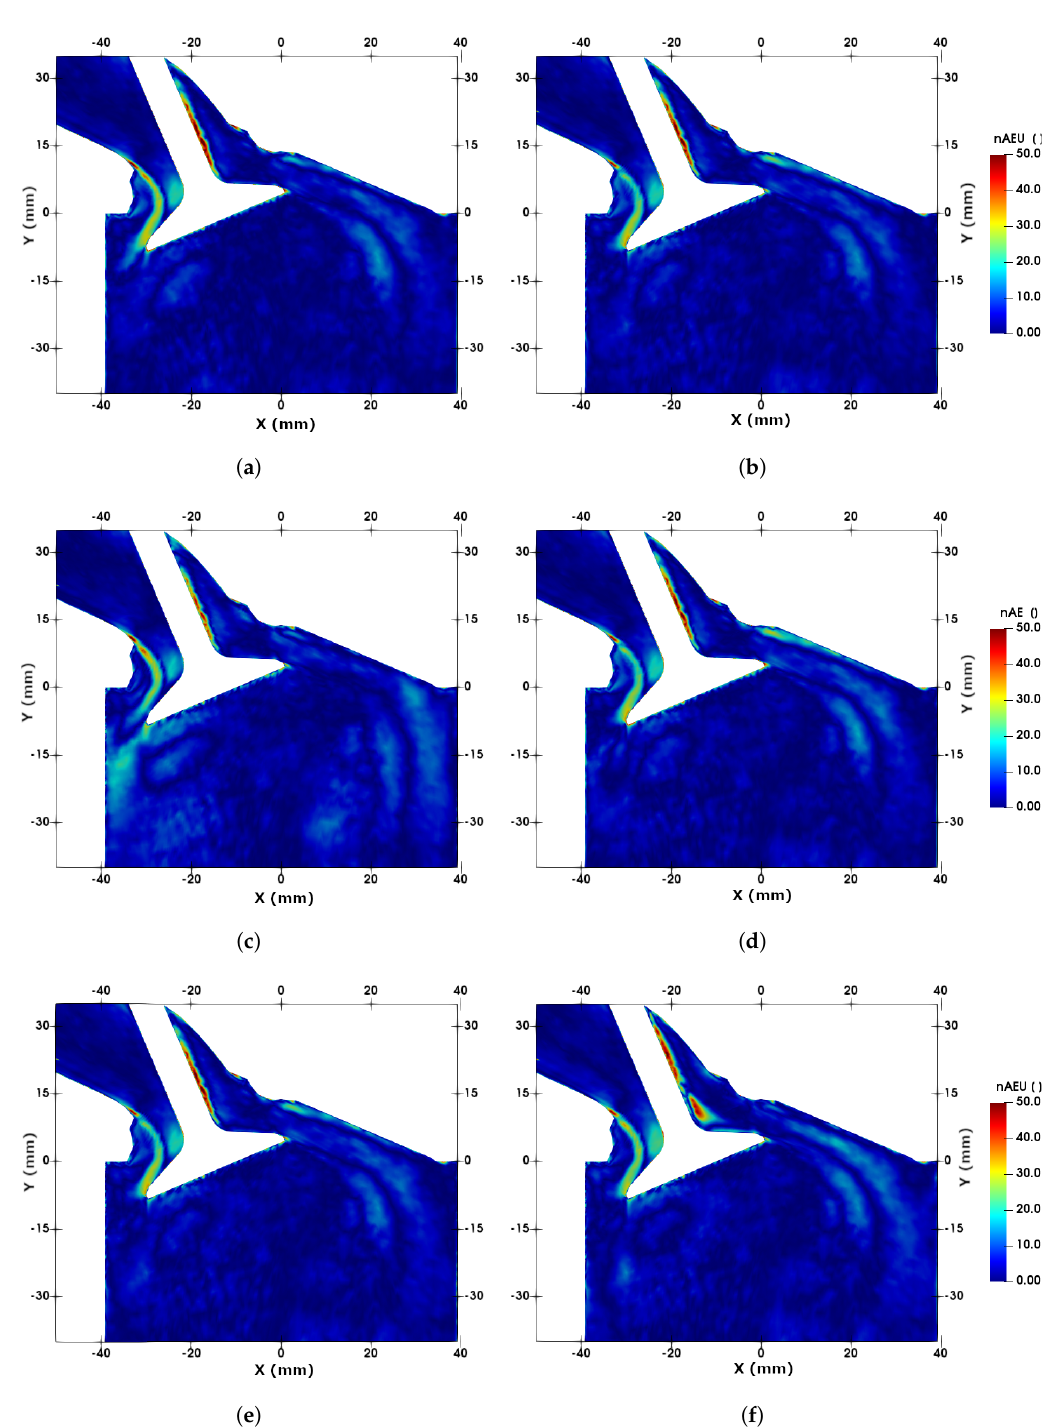
Figure 4. Evolution of normalized absolute error (nAE) for in-cylinder flow against MRV(Magnetic resonance velocimetry) data for various turbulence models. ( a ) WALE (fine mesh); ( b ) WALE (coarse mesh); ( c ) RANS (coarse mesh); ( d ) Dynamic one equation (coarse mesh); ( e ) SIGMA model (coarse mesh); ( f ) Smagorinsky Model (coarse